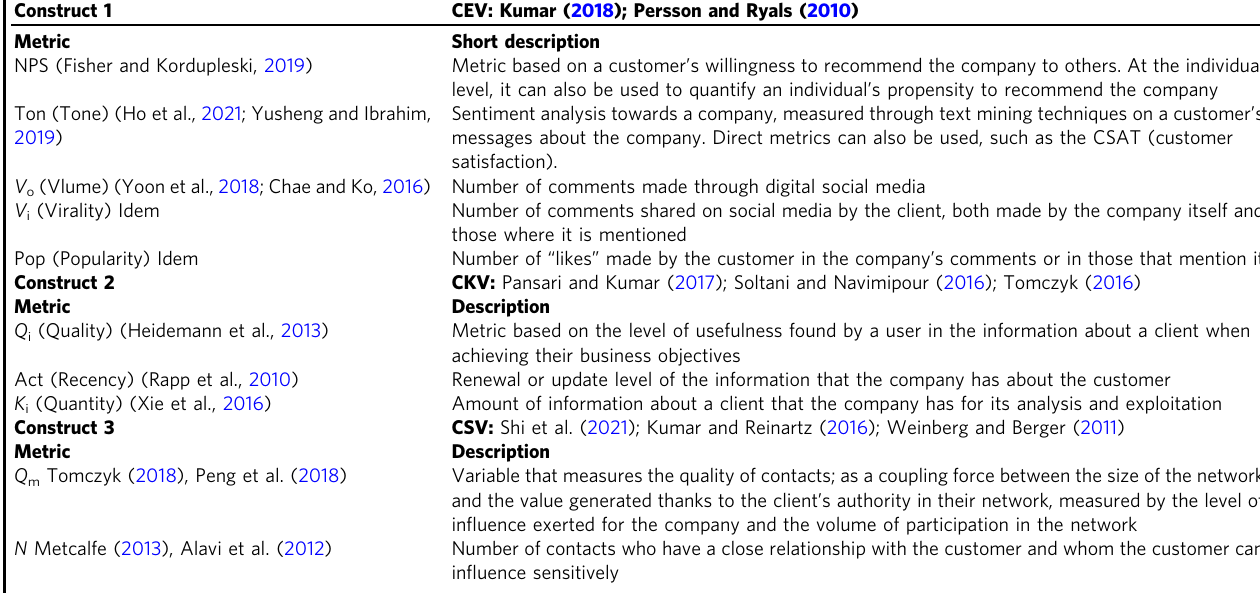
Table 1 Summary of the metrics of the constructs of f(CLV). Construct 1 CEV: Kumar (2018); Persson and Ryals (2010)